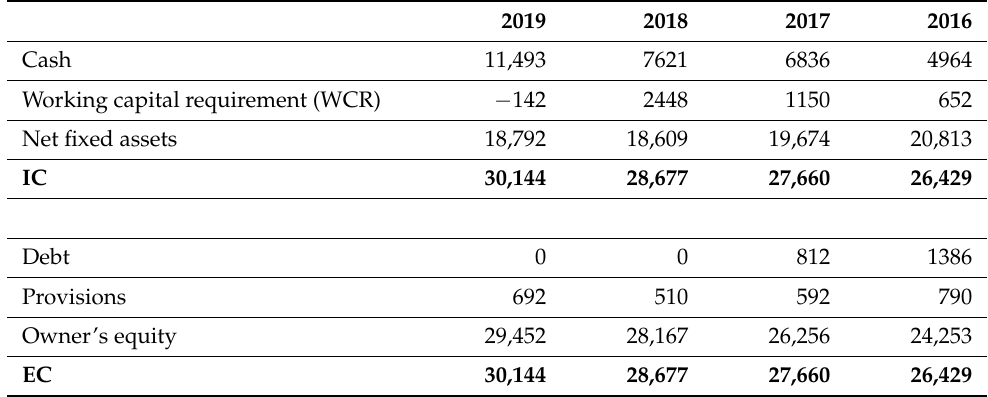
Table 7. Managerial balance sheet of Geotermia Mazowiecka S.A. (PLN thousand).